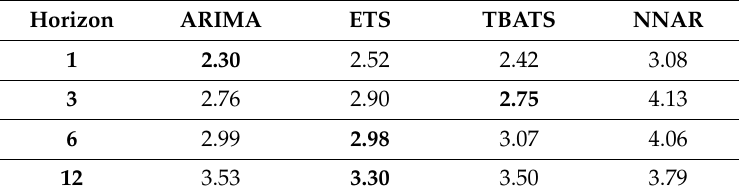
Table 1. Out-of-sample forecasting root mean square error (RMSE) results for “Burberry” fashion consumer Google Trends.